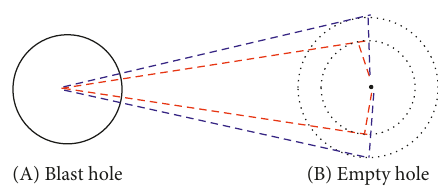
Figure 3: The influence of adjacent empty hole